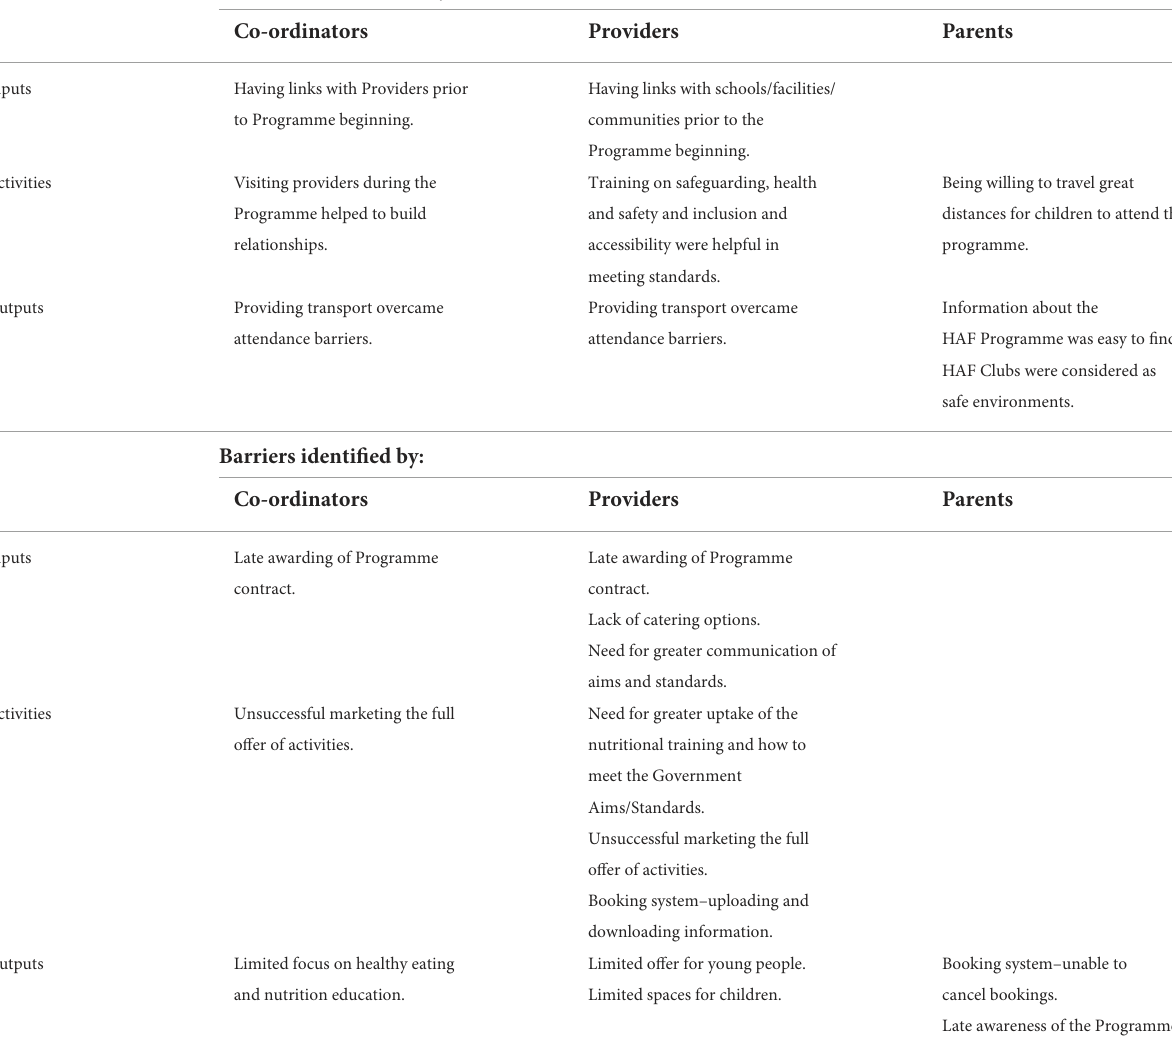
TABLE 2 Facilitators and Barriers to the delivery of the HAF Programme across different stages and stakeholders. Facilitators identified